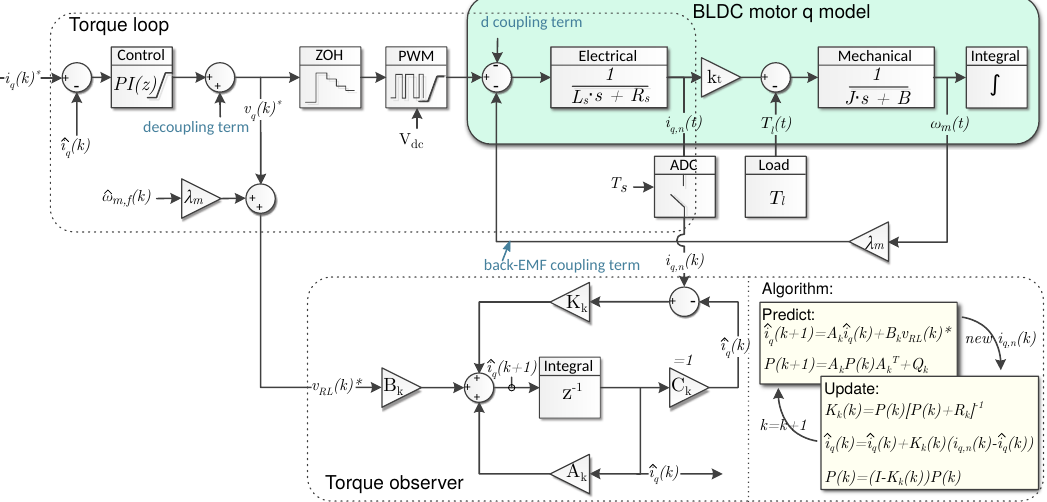
Figure 8. Illustration of the torque loop and torque observer proposed in this section. The light-yellow boxes outline the algorithms used for the observer. The decoupling term is proposed to be 0V but can be included if